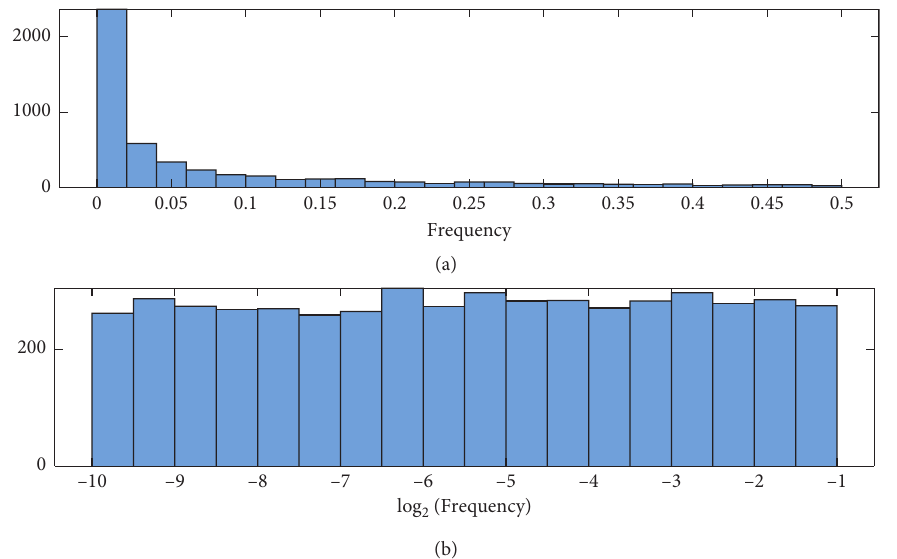
Figure 5: (a) Histogram of the randomly initialized center frequencies ω 1 initialized center frequencies log